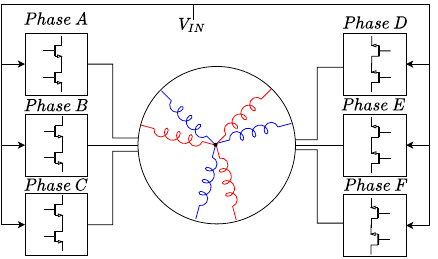
Figure 3. Diagram of the hardware configuration used in the case study.